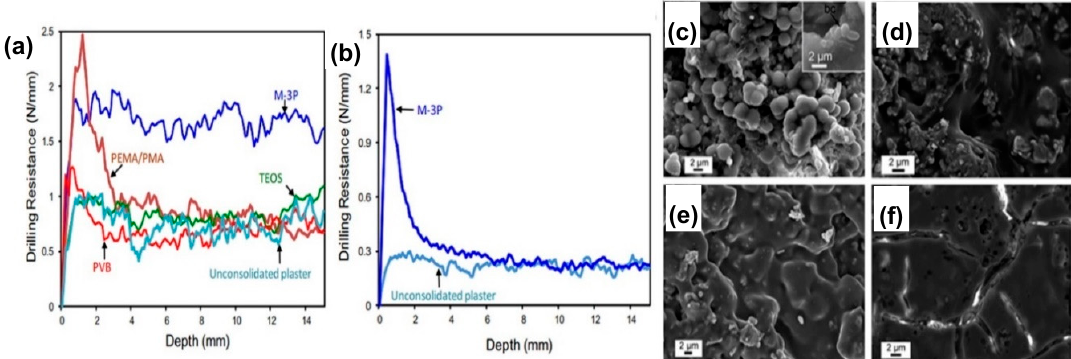
Figure 7. ( a ) Drilling resistance (DR) measured on gypsum plaster pieces, with an initial porosity of 29–38% and treated with three conventional consolidants and M-3P culture medium. ( b ) DR of untreated and bacterially treated gypsum plaster with an initial porosity of 48%. Values are averages of three to five drill holes. Samples treated with ( c ) M-3P, showing bacterial vaterite surrounded by EPS and bacterial cells (inset shows a magnification), ( d) poly(ethyl methacrylate-co-methacrylate) (PEMA/PMA), ( e ); polyvinyl butyral (PVB), and ( f ) tetraethyl orthosilicate (TEOS). Adapted with permission from [75] 2014, Elsevier.